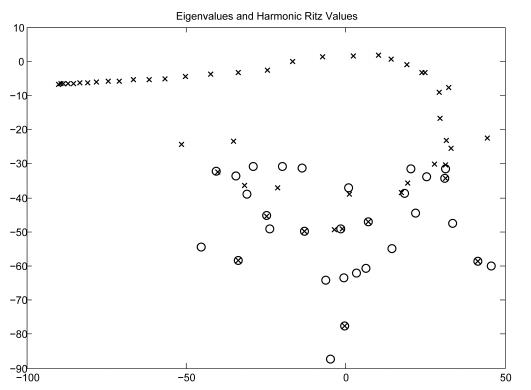
Figure 12: The first 30 eigenvalues of the system matrix with the smallest imaginary part (circles) and the first 100 harmonic Ritz values (crosses) for the plasmonic waveg- uide